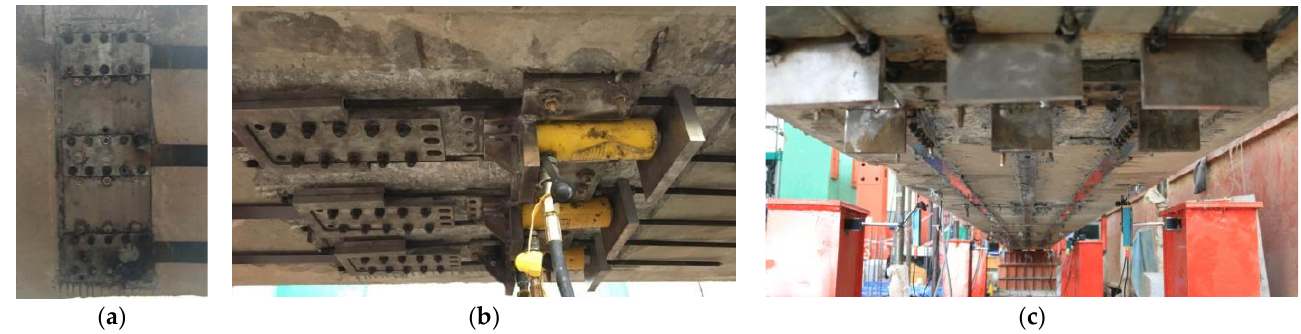
Figure 7. Photos of strengthened beam: ( a ) fixed end; ( b ) tensioning end; ( c ) strengthening completed.